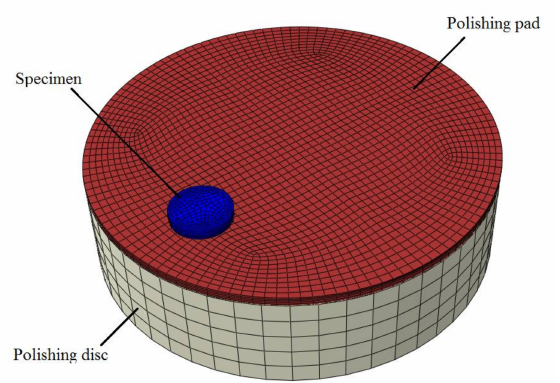
Figure 3. Finite element model of annular polishing of silicon carbide